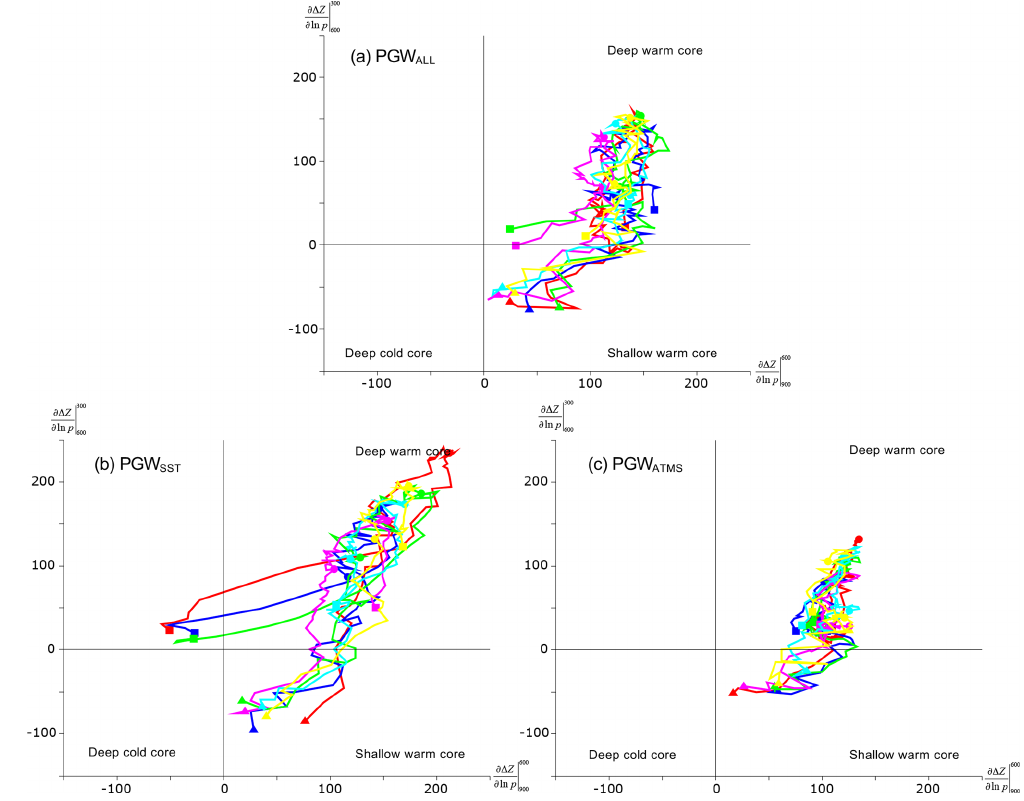
Figure 8. Same as Fig. 3b, but for (a) PGW ALL , (b) PGW SST , and (c) PGW ATMS